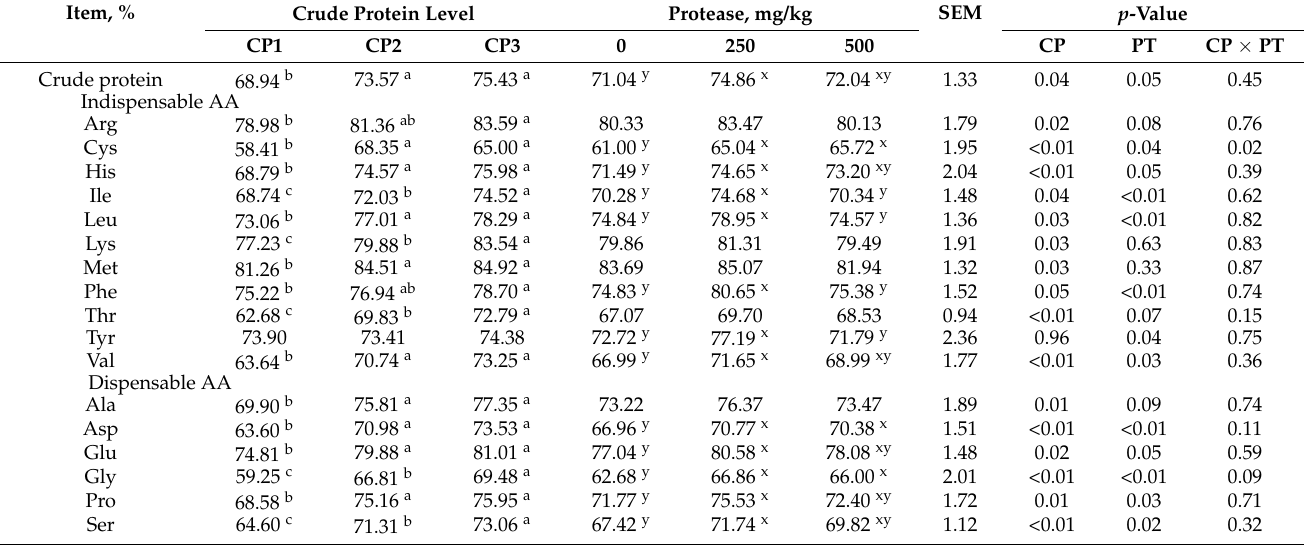
Table 7. Effects of dietary crude protein and protease levels on crude protein and apparent ileal essential AA digestibility coefficients of